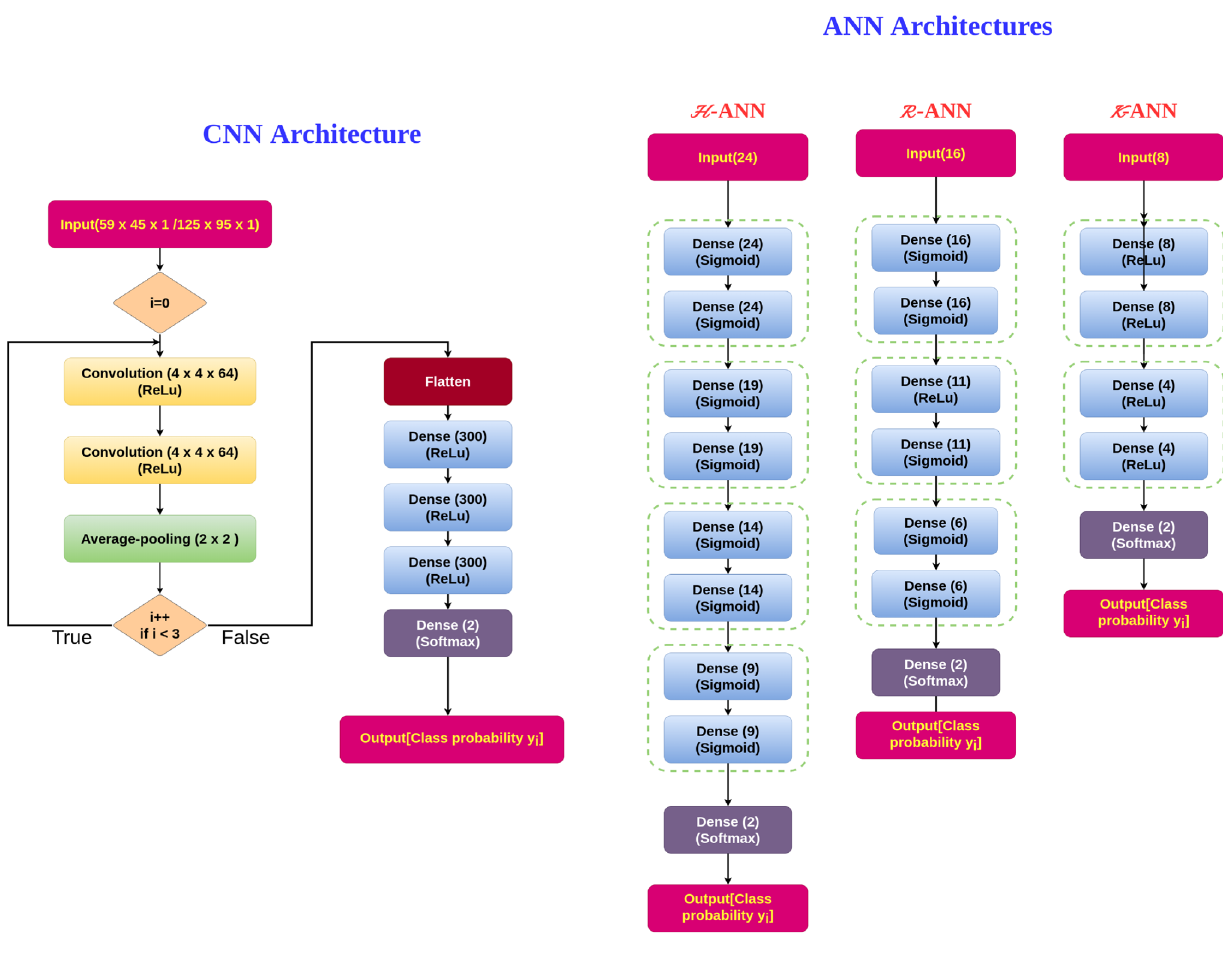
Fig. 10 Simplified architecture of (left) CNNs and (right) ANNs